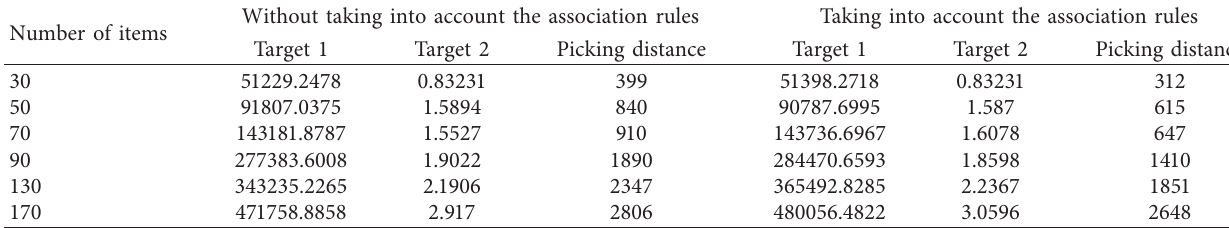
Table 5: The optimization values for each single target.